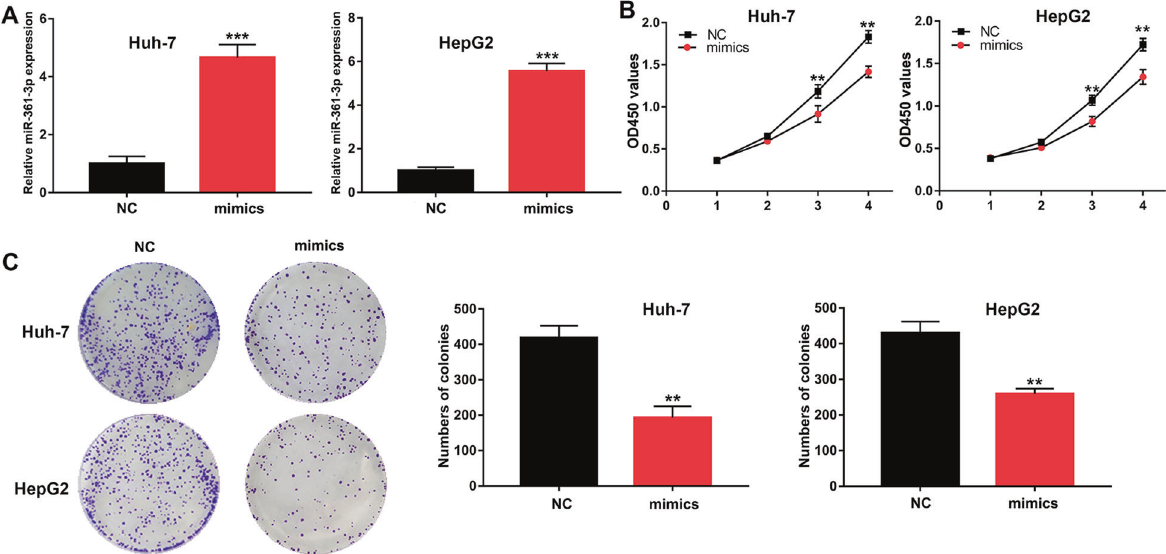
Fig. 4 miR-361-3p inhibits cell proliferation in HCC cells. A Relative miR-361-3p expression in transfected Huh-7 and HepG2 cells. B , C CCK-8 and colony formation assays evaluating the cell proliferative effects of miR-361-3p in Huh-7 and HepG2 cells. Data ( n = 5) are the means ± SD. *P < 0.05, ** P < 0.01, *** P <